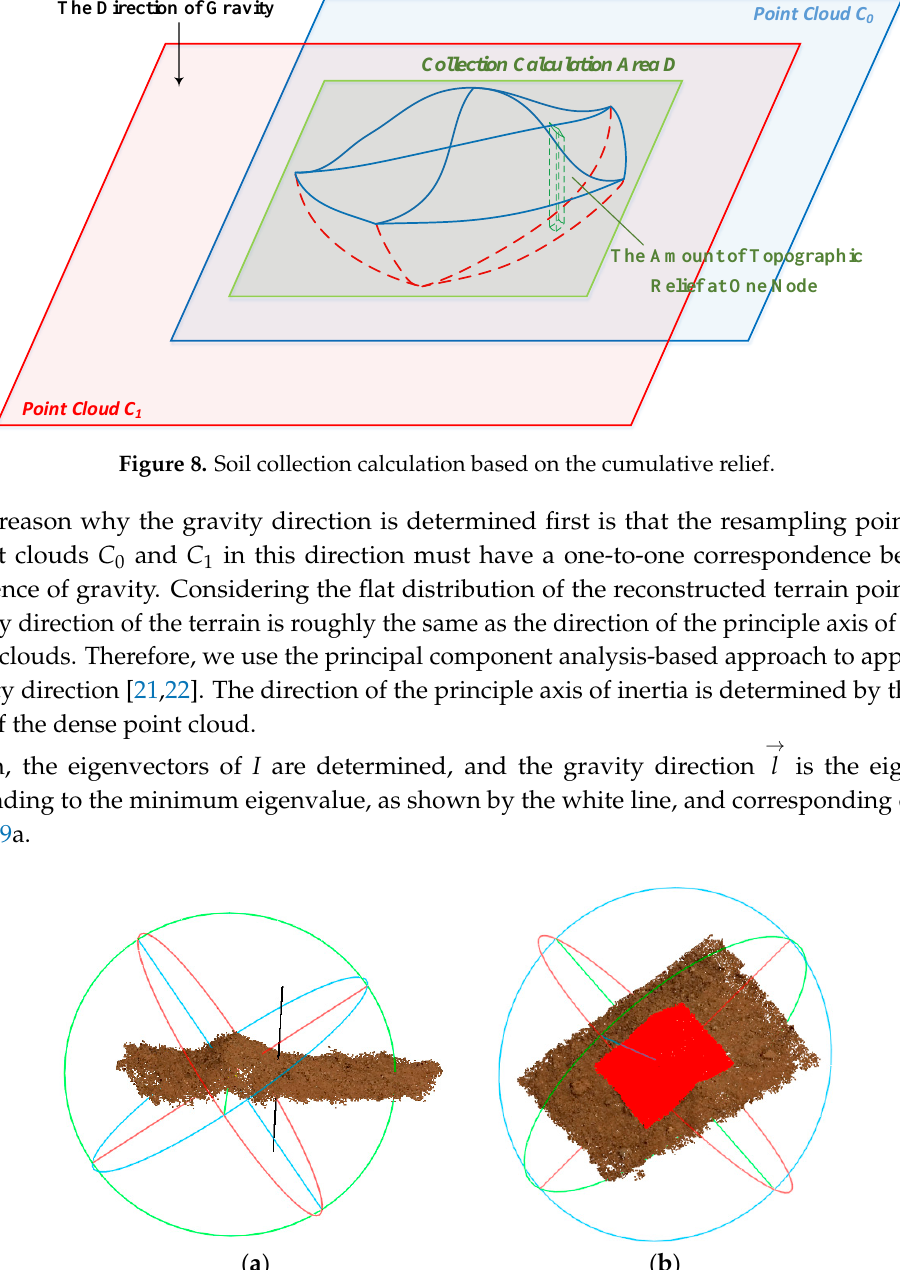
Figure 9. The gravity direction and collection calculation area based on the reconstructed point clouds. ( a ) Estimation of the gravity direction; ( b ) The collection calculation area D.